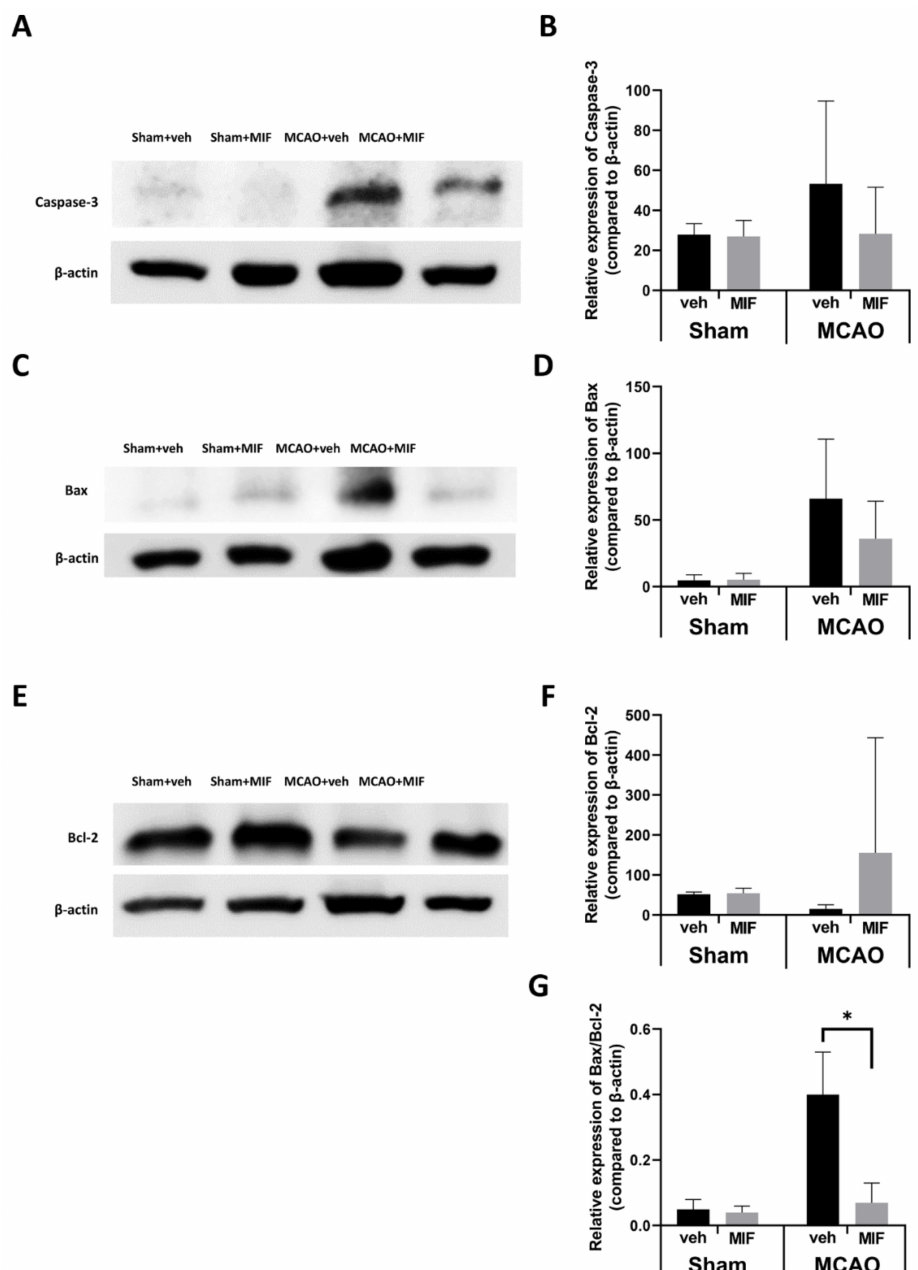
Figure 5. Changes in apoptosis markers: ( A , C , E ) representative Western blot bands in each group; ( B ) caspase-3 expression in the sham and MCAO groups were analyzed respectively by a t -test; the expression level of caspase-3 in the sham group did not change significantly with an MIF injection ( p = 0.756); the expression level of caspase-3 in the MCAO+MIF decreased insignificantly compared to the MCAO+veh ( p = 0.082); ( D ) The expression level of Bax decreased in the MCAO+MIF group compared to that in the MCAO+veh group; however, it was not significant ( p = 0.082); ( F ) the expression level of Bcl2 in the sham group did not change significantly with an MIF injection ( p = 0.514); Bcl2 expression increased in the MCAO+MIF group compared to that in the MCAO+veh group, but it was not significant ( p = 0.107); ( G ) the Bax/Bcl-2 ratio was significantly decreased in the MCAO+MIF group compared to the MCAO+veh (* p < 0.0001); caspase-3, Bax, Bcl-2, and Bax/Bcl2 expression of the sham and the MCAO groups were compared, respectively, in each group using a t -test. Mean ± SD values are presented from 12 independent experiments. MCAO: middle cerebral artery occlusion; MIF: macrophage migration inhibitory